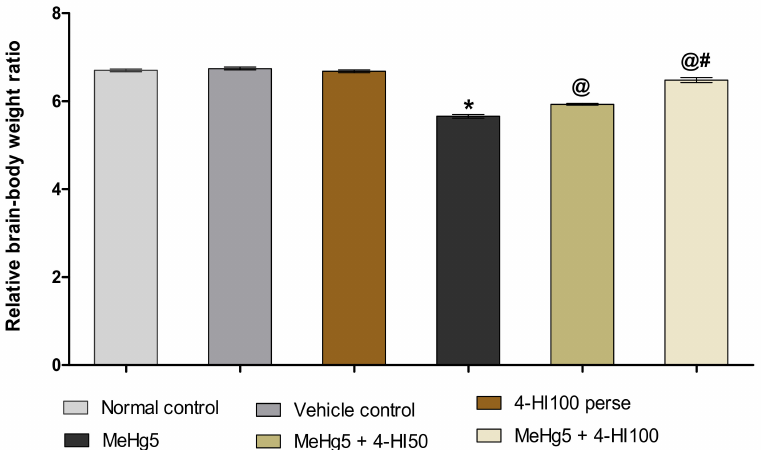
Figure 3. Effect of 4-hydroxyisoleucine on relative brain–body weight ratio after methyl mercury- exposure in rats. Statistical analysis by one-way ANOVA (posthoc Tukey’s test). Values are expressed as mean ± SEM ( n = 6 rats per group). * p < 0.001 v/s normal control, vehicle control and 4-HI100 perse ; @ p < 0.001 v/s MeHg5; @# p < 0.001 v/s MeHg5 +